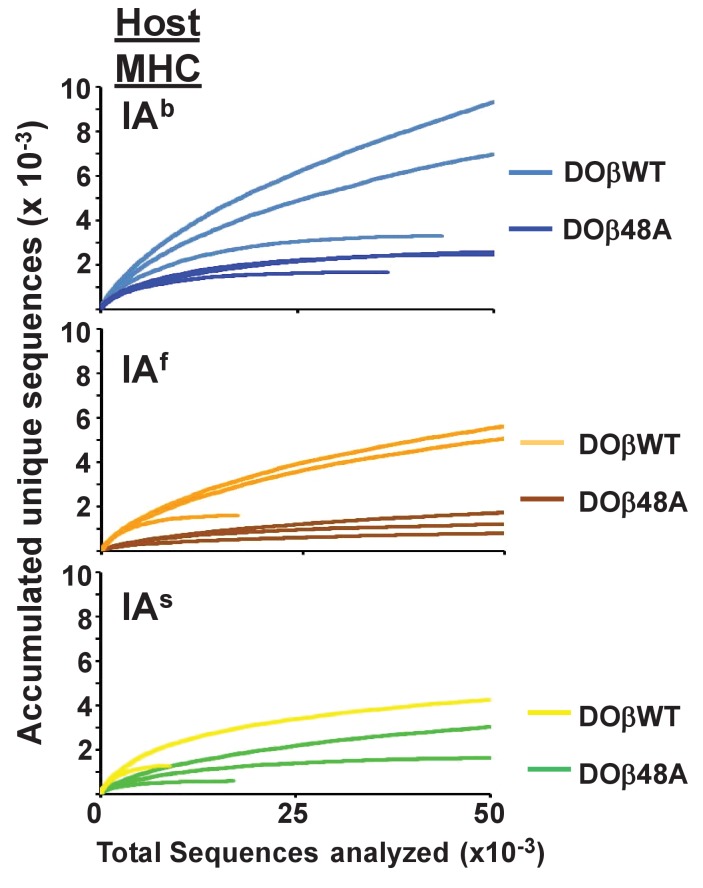
The naïve CD4 T cells in mice expressing a single TCRa chain express a limited number of TCRα sequences regardless of the MHC allele involved in their selection in the thymus.Results were calculated as described in Figure 3. Data shown are for individual mice.